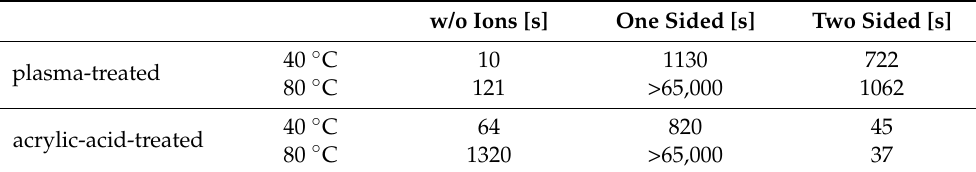
Table 1. Debonding time of various samples upon immersion in water at room temperature, w/o ions = without ions, one sided = only one of the two bonded substrates had been loaded with copper(II) ions, two sided = both sides of the bonded substrates had been loaded with copper(II) ions. The temperature represents the bonding temperature of the samples. One sample per experiment was